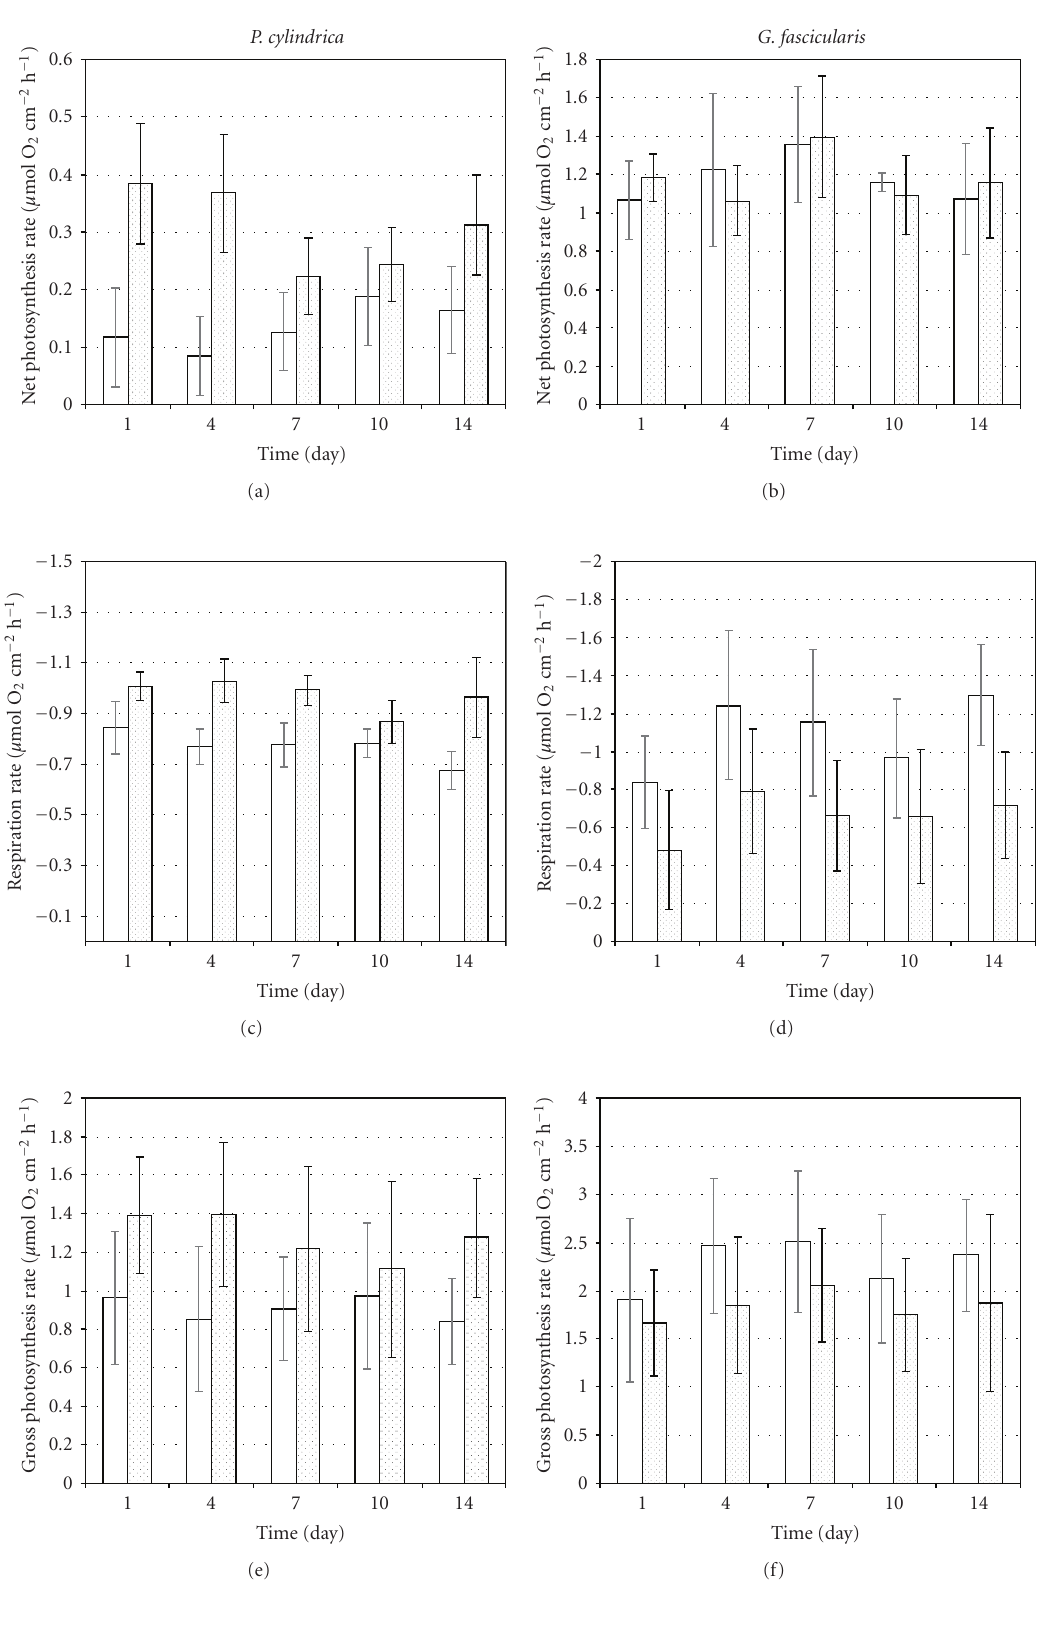
Figure 1: Changes in net photosynthesis, respiration, and gross photosynthesis in P. cylindrica and G. fascicularis under normal and elevated p CO 2 . Open bar ( ) indicates elevated p CO 2 while dotted bar ( ) indicates control